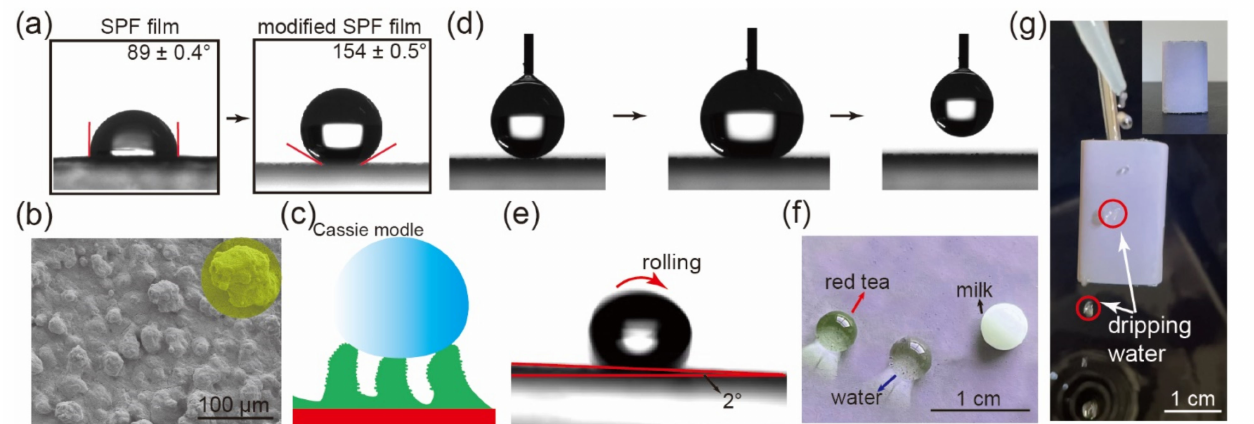
Figure 7. ( a ) CAs of unmodified SPF films and modified SPF films. ( b ) SEM image of the modified composite film surface. ( c ) Scheme diagram of lotus super-hydrophobicity. ( d ) The adhesion of the film. ( e ) Sliding angle of modified composite film. ( f ) Digital photo of the droplet of different liquid on the surface of the films. ( g ) The digital image of the dripping water of the SPF packing